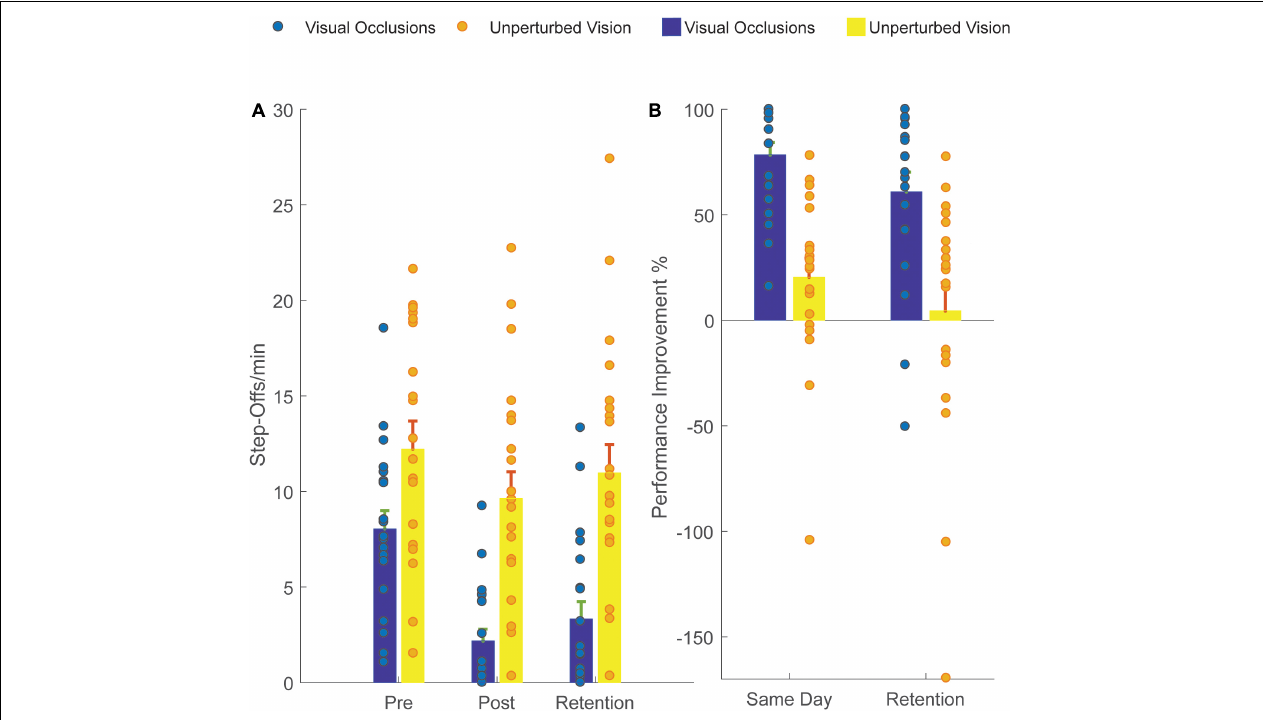
FIGURE 2 | Balance Improvement for the Unperturbed Vision group (light colors – yellow/orange) and the Visual Occlusions group (dark colors – blue/green). (A) Step-Offs/min on the Same Day before (Pre) and after (Post) the Training and Two Weeks Later. (B) Performance improvement was calculated from the difference between Pre Step-Offs/min and Post Step-Offs/min, normalized to Pre Step-offs/min value. The intermittent visual occlusions improved training outcomes compared to unperturbed vision (ANOVA, p < 0.001). The error bars represent the standard error of the mean. Visual Occlusions had a fourfold percentage performance improvement compared to not having visual perturbations.